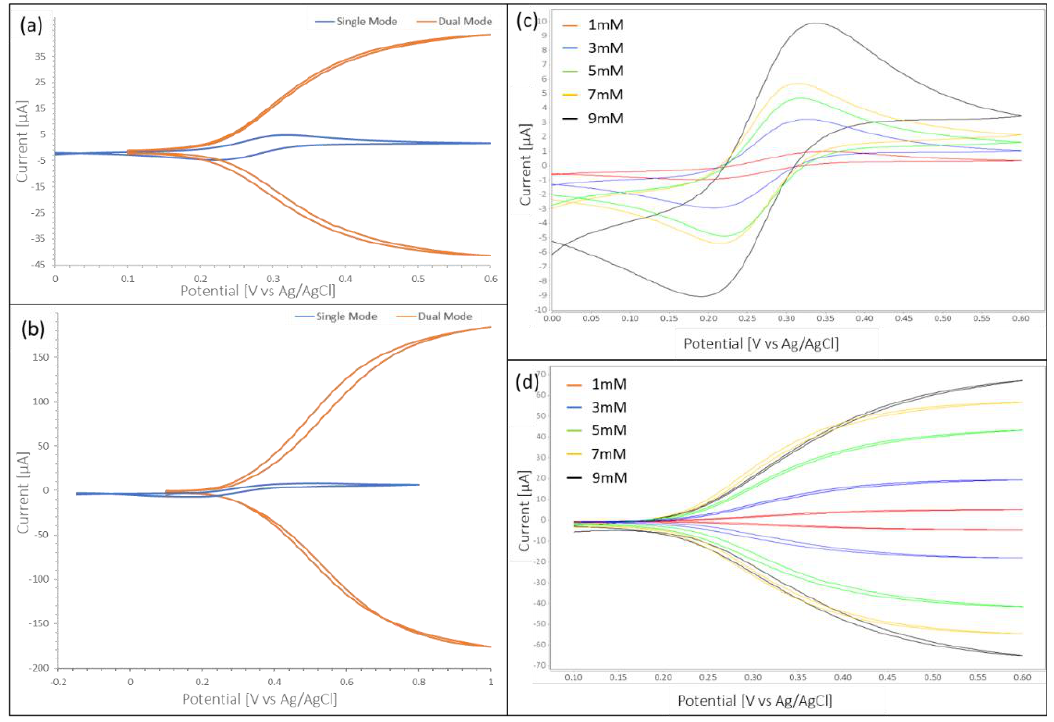
Figure 2. Single and dual mode cyclic voltammetry (CV) for ( a ) Platinum Interdigitated Electrode Array (IDA) and ( b ) carbon IDA, ( c ) Single mode CV for platinum IDA with concentrations 1 mM through 9 mM ferricyanide, ferrocyanide redox-couple, ( d ) Dual mode CV for platinum IDA with concentrations 1 mM through 9 mM ferricyanide, ferrocyanide redox-couple.